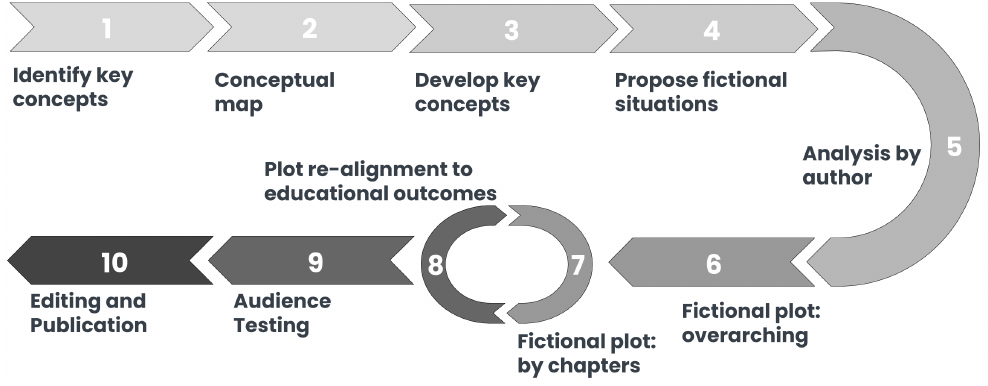
Figure 1. Novelette design process